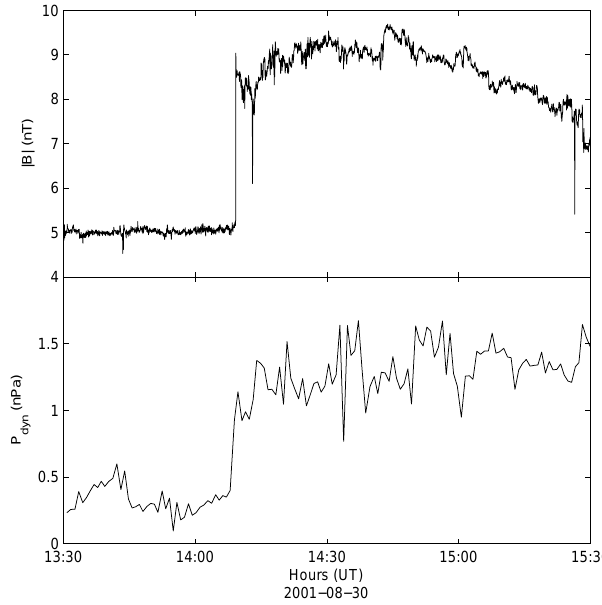
Fig. 2. L -value, polar angle in SM-coordinates and MLT for SC 1 (black), SC 2 (red), SC 3 (green) and SC 4 (blue).